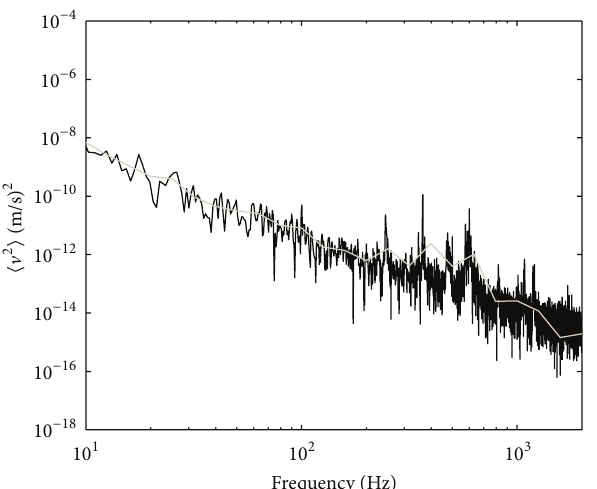
Figure 15: The damping loss factor of the low mobility reception